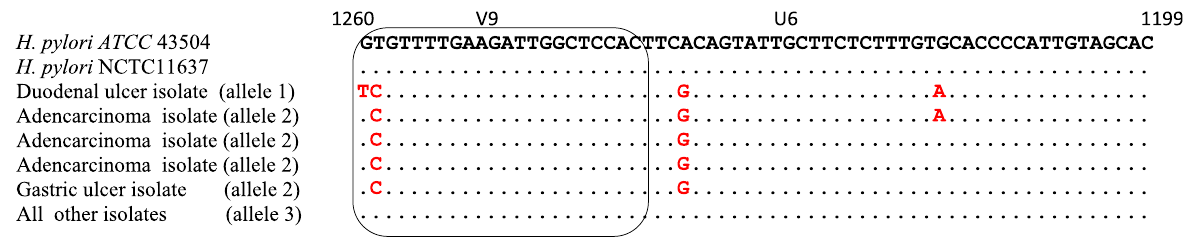
Fig. 2 Chromatograms of gel-purified PCR fragments. a Unidentified sequences with multiple bands and base substitutions. b H. pylori 16rRNA gene